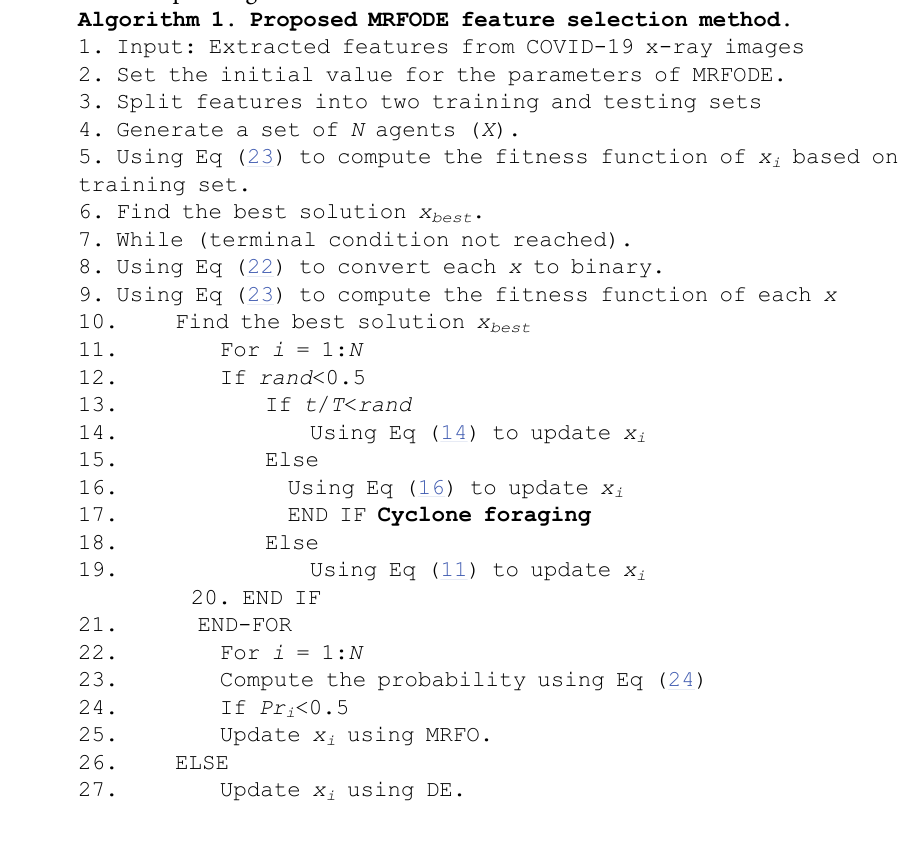
Algorithm 1. Proposed MRFODE feature selection